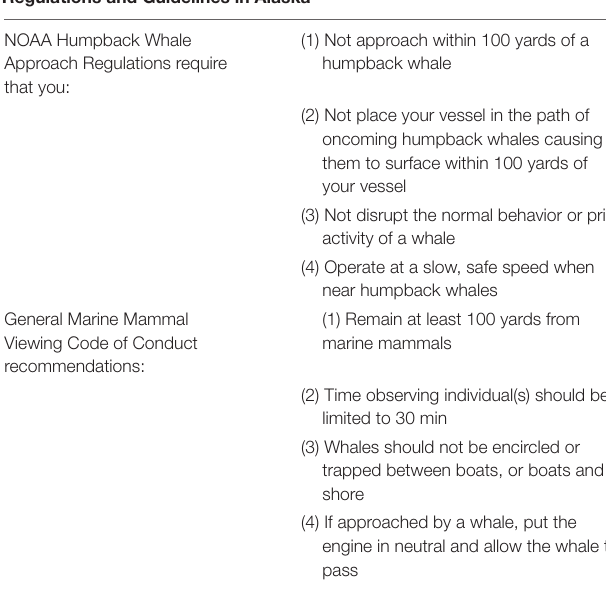
TABLE 1 | Federal regulations and guidelines for viewing humpback whales and marine mammals in Alaska (National Oceanic and Atmospheric Administration, 2016).